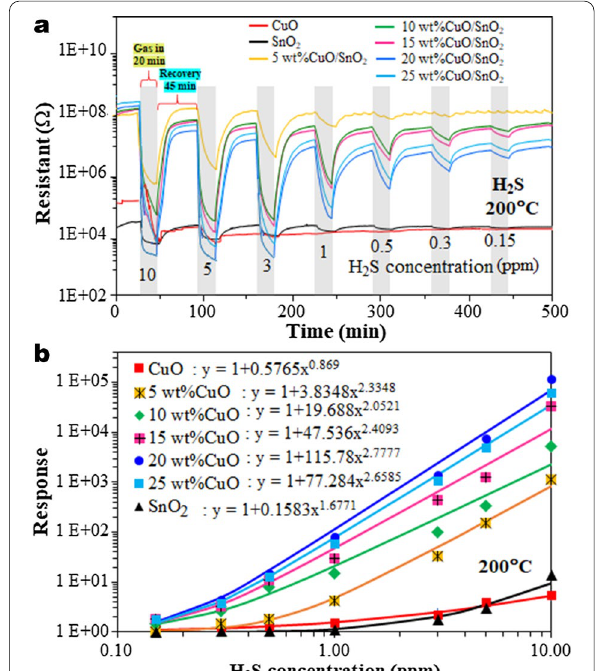
Fig. 8 a Dynamic response of CuO, SnO 2 and 5–25 wt%CuO/SnO 2 gas sensors subjected to 0.15 to 10 ppm H 2 S pulses at 200 °C and b corresponding sensor response vs. H 2 S